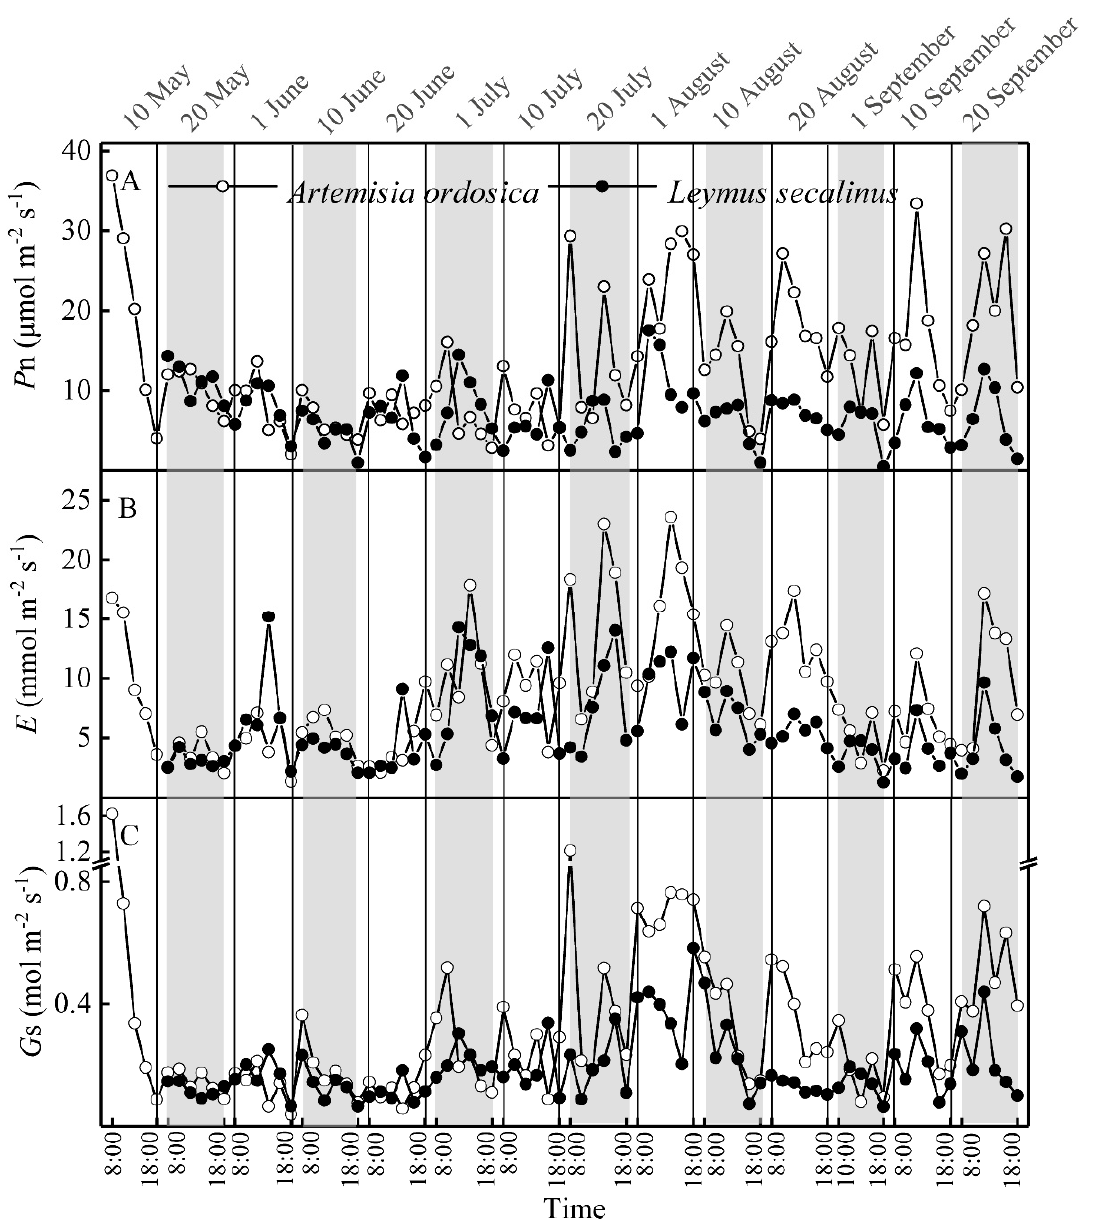
Figure 3. Diurnal variation in rates of photosynthesis ( P n, ( A )), transpiration ( E , ( B )), and stomatal conductance ( G s, ( C )) for A. ordosica and L. secalinus during a five-month field campaign from 1 May − 30 September 2019. Photosynthetic parameters for L. secalinus are missing during the 1 − 10 May period.